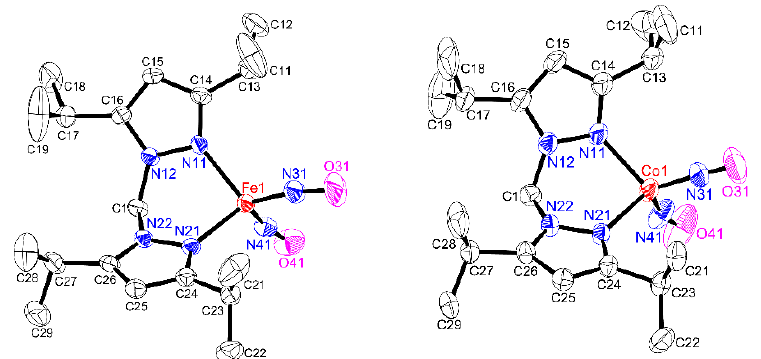
Figure 1. Crystal structures of [Fe(NO) 2 (L1”)] + (left), [Co(NO) 2 (L1”)] + (right) showing 50% displacement ellipsoids and the atom labeling scheme. BF 4 − counter ion, hydrogen atoms, and solvents were omitted for reasons of clarity. Relevant bond lengths (Å) and angles (°): Fe1–N11, 2.023(4); Fe1–